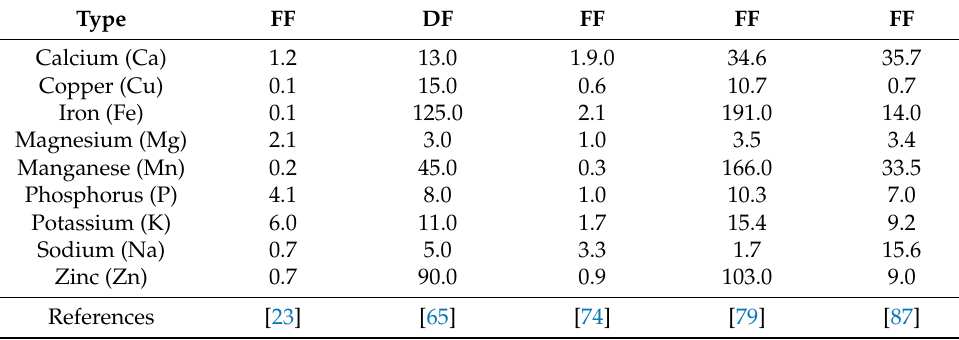
Table 4. Mineral compositions of BSFL (g kg − 1 dry matter